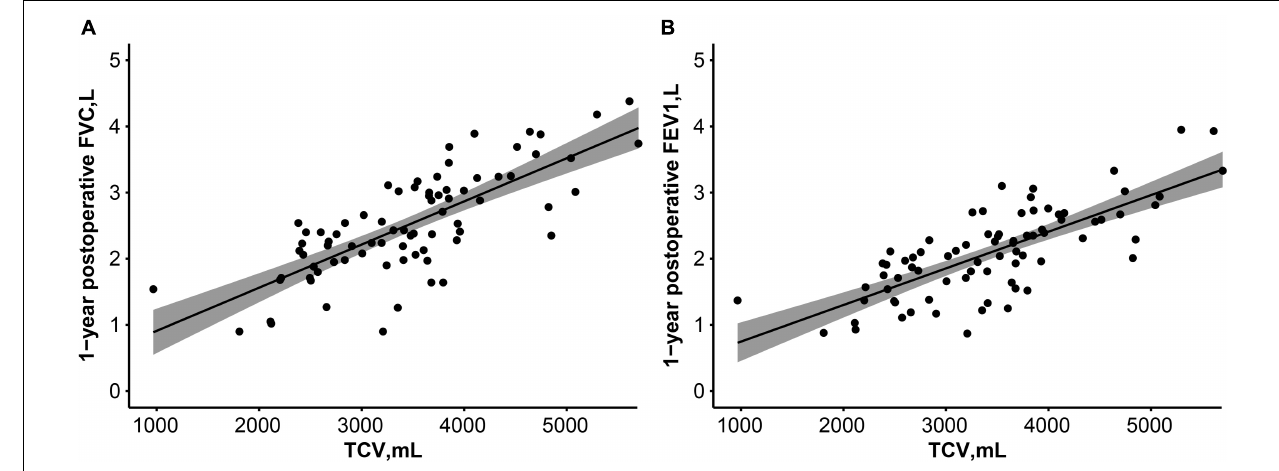
FIGURE 4 | Correlation between postoperative 1-year TCV and pulmonary function test [FVC, L (A) , FEV1, L (B) ]. Lines and dark areas show the regression lines and 95% confidence interval, respectively. FVC, forced vital capacity; FEV1, forced expiratory volume in 1 s.